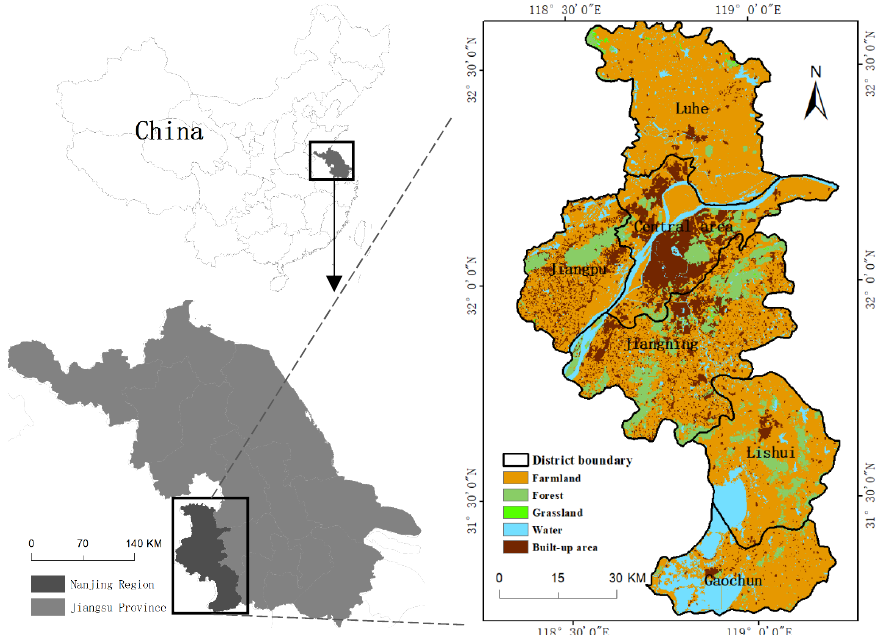
Figure 1. Location of the study area showing the land-use types obtained from GlobeLand 30 in 2010.